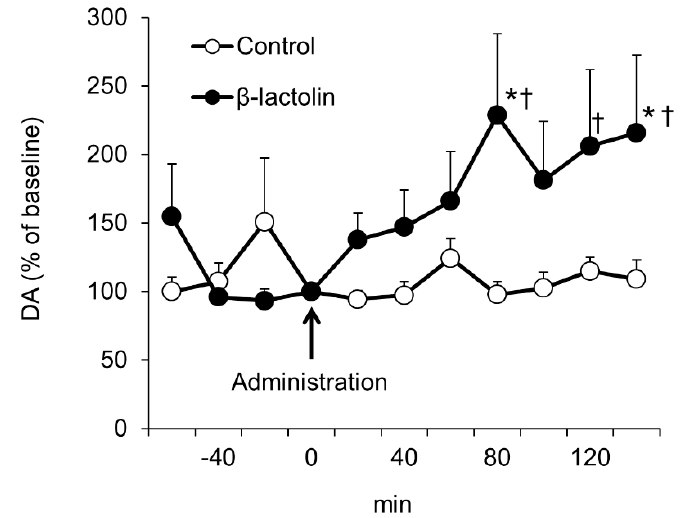
Figure 1. Oral administration of β -lactolin increased the extracellular concentration of dopamine in the hippocampus. Male ICR mice were orally administered β -lactolin (0 or 1 mg / kg), and CSF was collected from the hippocampus via a microdialysis probe, every 20 min between 60 and 140 min post-administration. The DA levels in the collected CSF were quantified using HPLC-ECD. Each value was expressed as the percentage of change from the baseline (DA level at 0 min) of each mouse. Results are presented as the mean ± SEM ( n = 9–13 mice per group). * p < 0.05 versus control (0 mg / kg) group, † p < 0.05 versus the baseline of the same group.